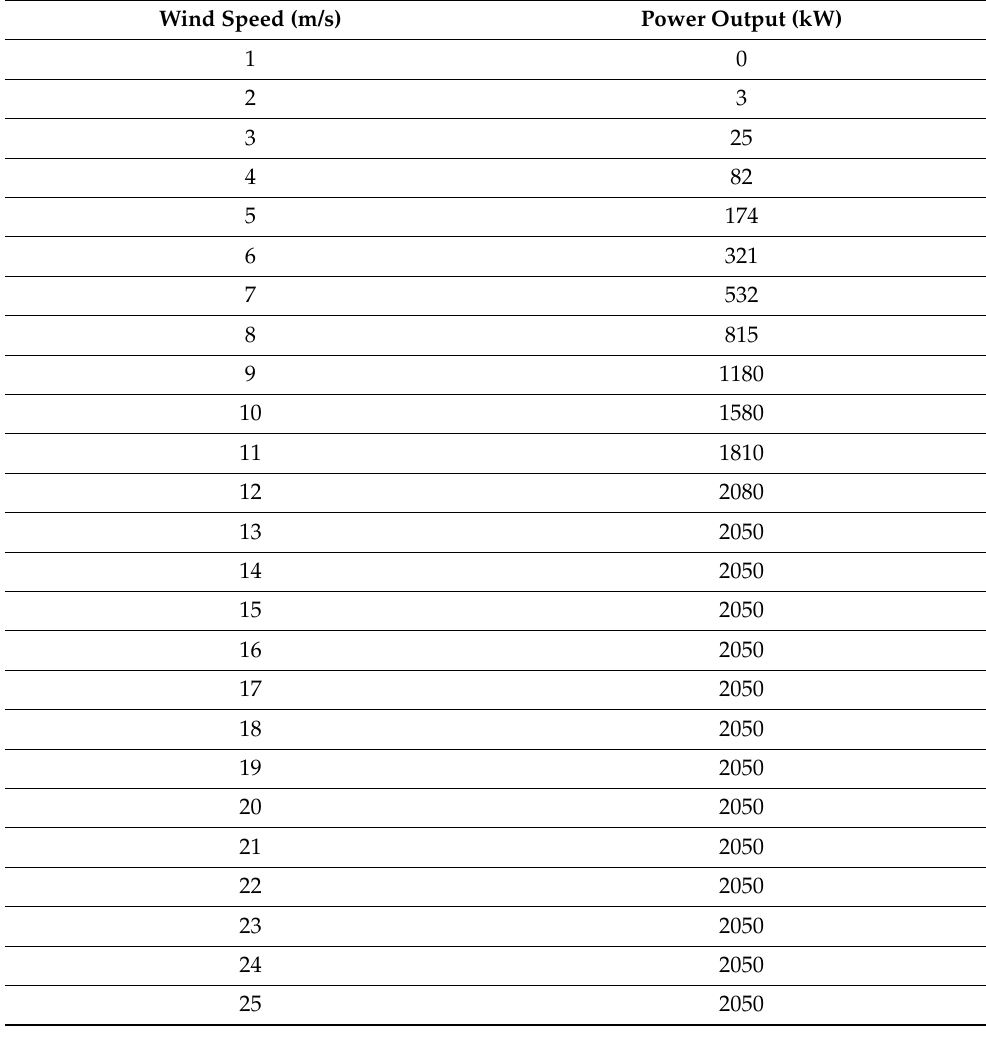
Table A1. Wind speed and corresponding power